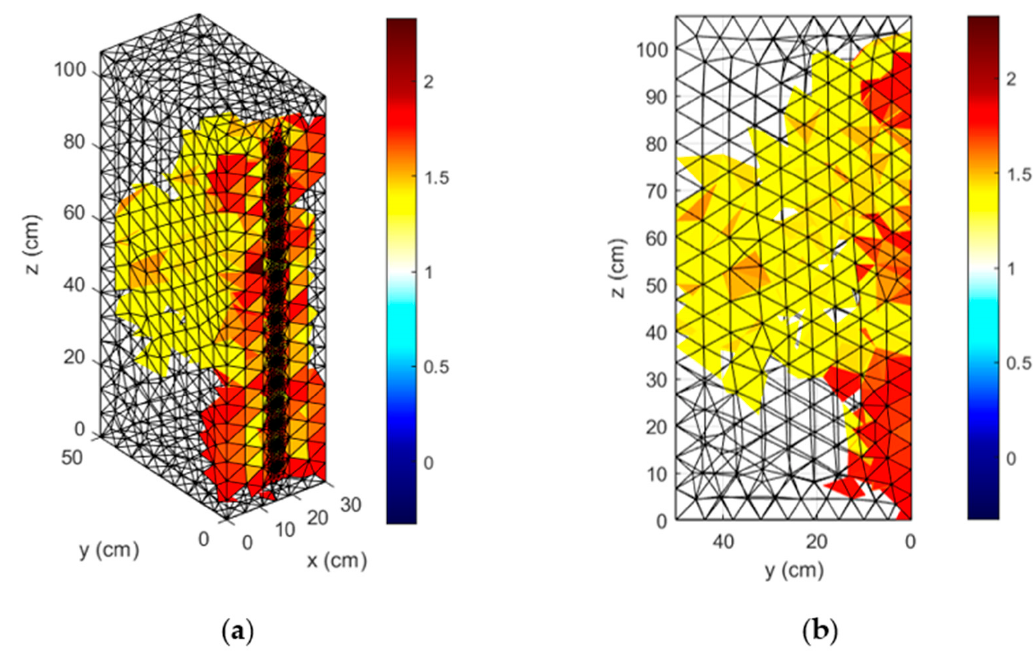
Figure 13. Reconstruction of real measurements made in a historical building located on the Partisan Hill in Wroclaw, Poland using the ANN method: ( a ) spatial view, ( b ) side view. The further away from the electrodes, the greater the differences.